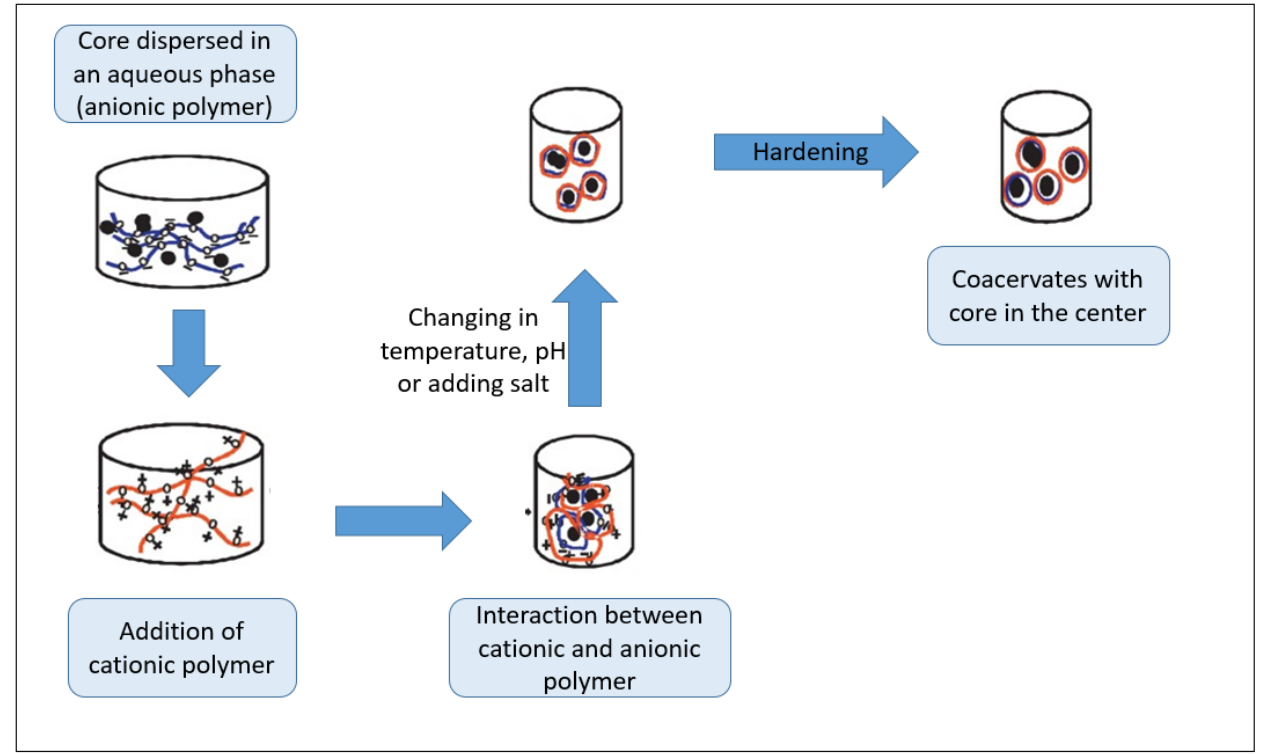
Figure 4. Coacervation process adapted from Reference [105]. The bioactive molecule to be encapsulated (core) is first mixed with one polymer before adding the oppositely charged polymer. The complex coacervation process is generally spontaneous or induced by altering the physicochemical parameters (pH, temperature, ionic strength, etc.). This process leads to the formation of micrometric droplets (5–10 µm) with entrapped bioactive molecules. At the end, stabilization can be performed using chemical or physical treatments.